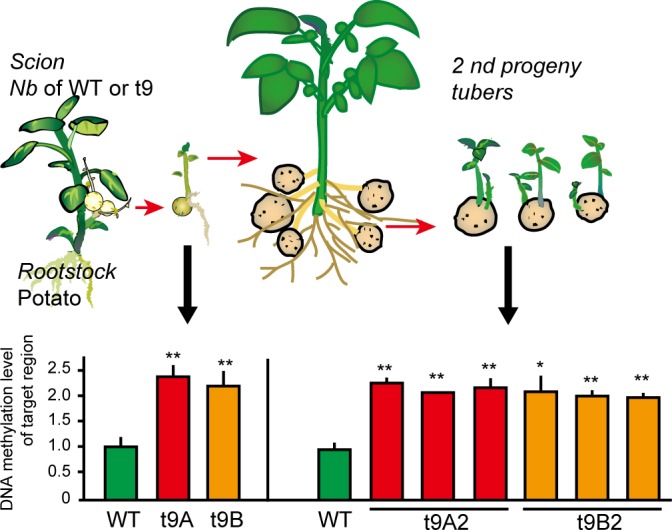
DNA methylation in the MTs formed trans-grafting plant and its stability in the progenies.Two MTs formed on a grafted plant and their progeny tubers were analyzed. Actually, the sprouts from tubers were used as analyzing materials. Asterisks show statistically significant (*; p<0.05, **; P<0.01 Student's t test) differences relative to WT. Means and SD of 3 biological replicates are shown.